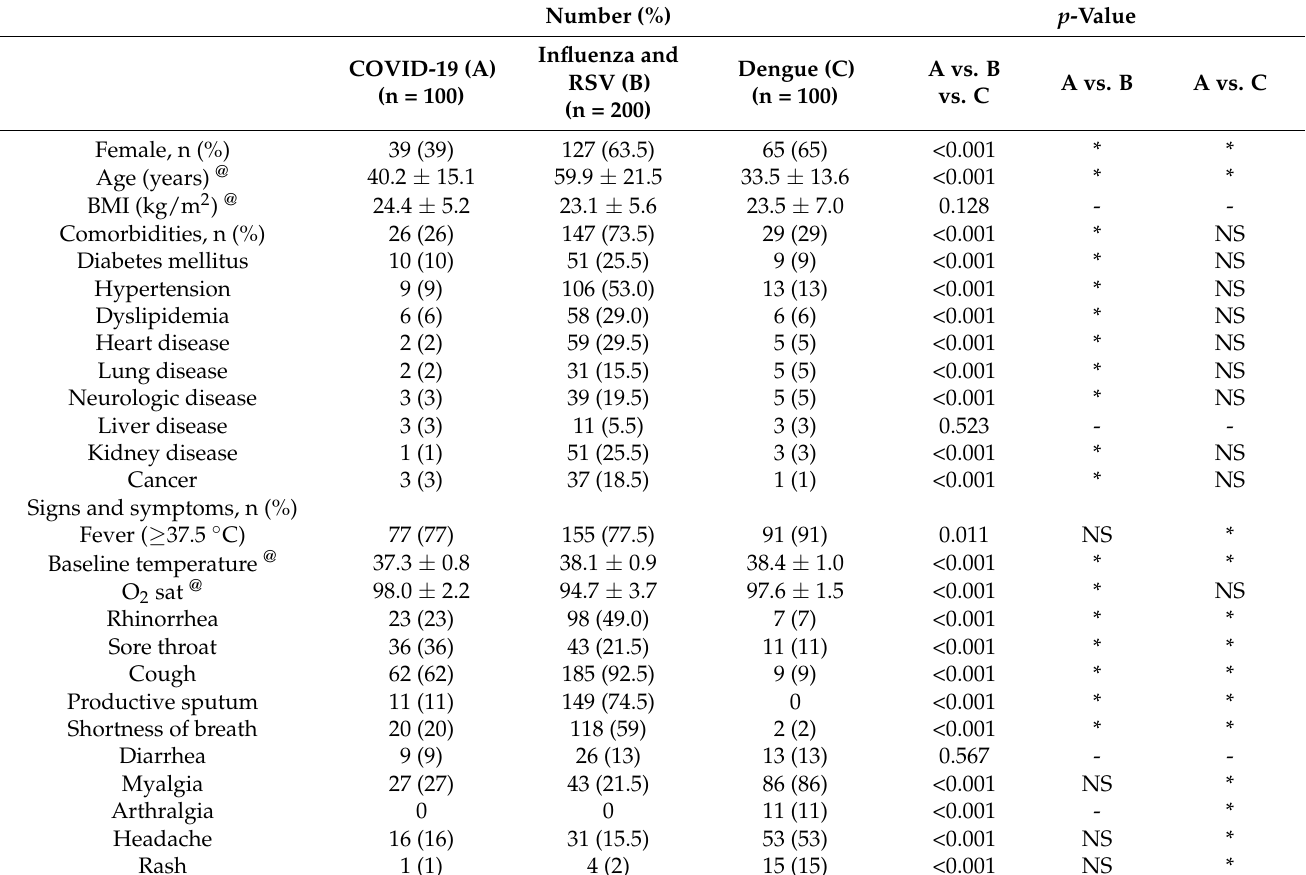
Table 3. COVID-19 vs. common respiratory viruses (influenza and RSV) vs. dengue infection. Number (%) p